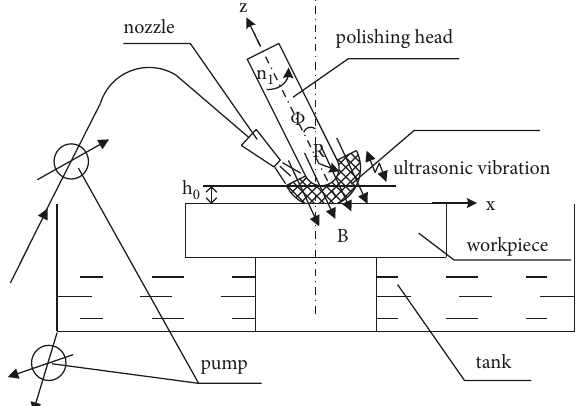
Figure 30: Ultrasonic-magnetorheological compound finishing